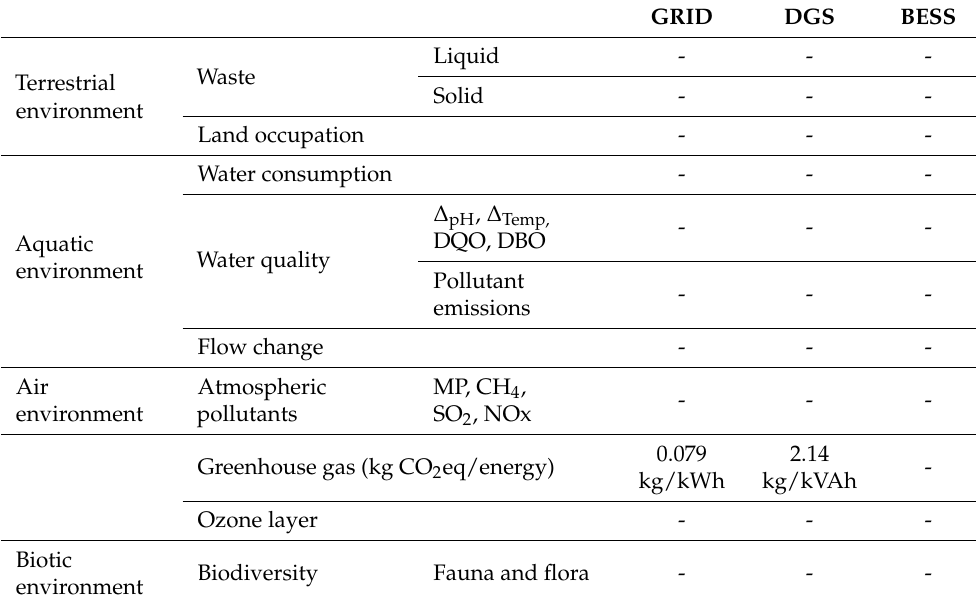
Table 7. Environmental dimension assessment under RCPA tool for GRID (3rd column), the DGS (4th column) and the BESS (5th